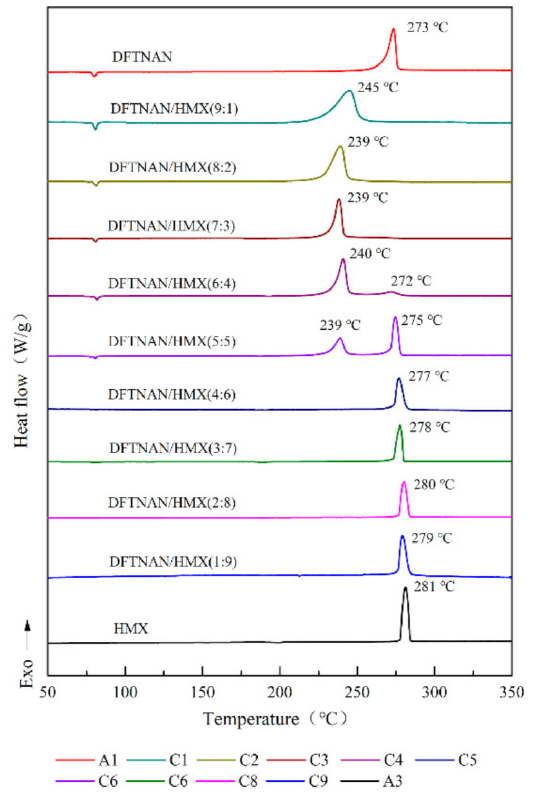
Figure 6. DSC curves of DFTNAN, HMX and mixtures with different